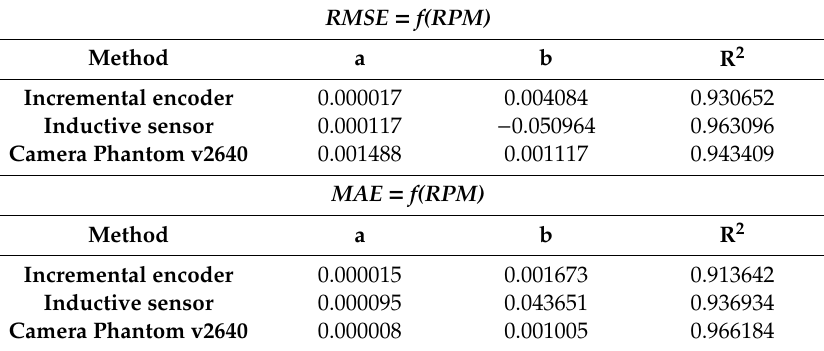
Table 1. Matching parameters of linear functions described with Equation (2). RMSE = f(RPM)